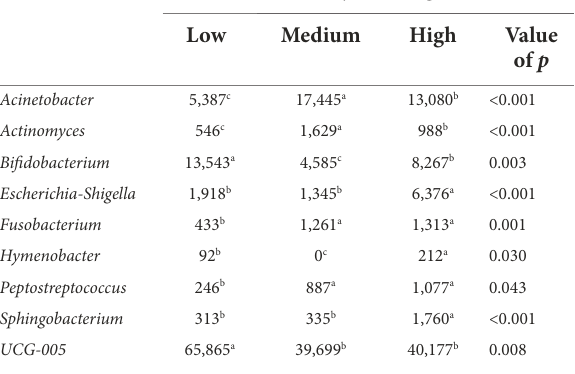
TABLE 6 Bacterial genera relative abundance (ppm) in the milk samples of Holstein dairy cattle associated with different milk yield ranges at time of collection: low, medium, and